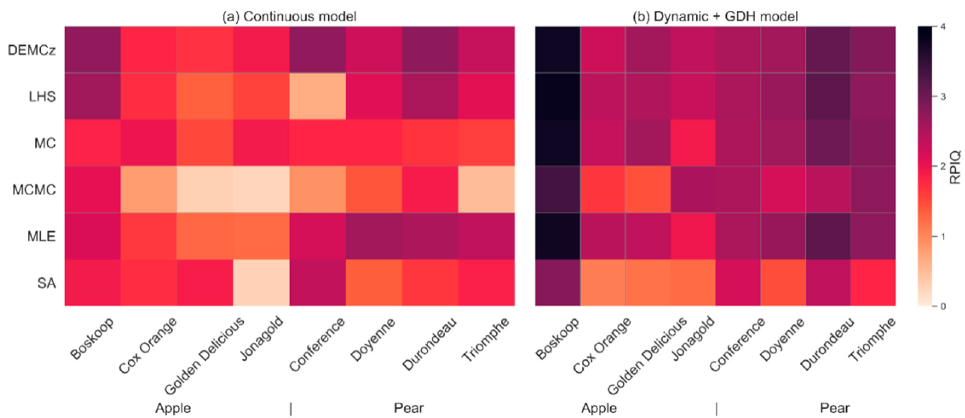
Figure 8. Ratio of performance to interquartile distance (RPIQ) for all cultivars and algorithms for the continuous model ( a ) and the dynamic + GDH model ( b ). Mean indices were 1.6 for apple and 1.9 for pear using the continuous model; and 2.4 for apple and 2.6 for pear using the dynamic + GDH model.